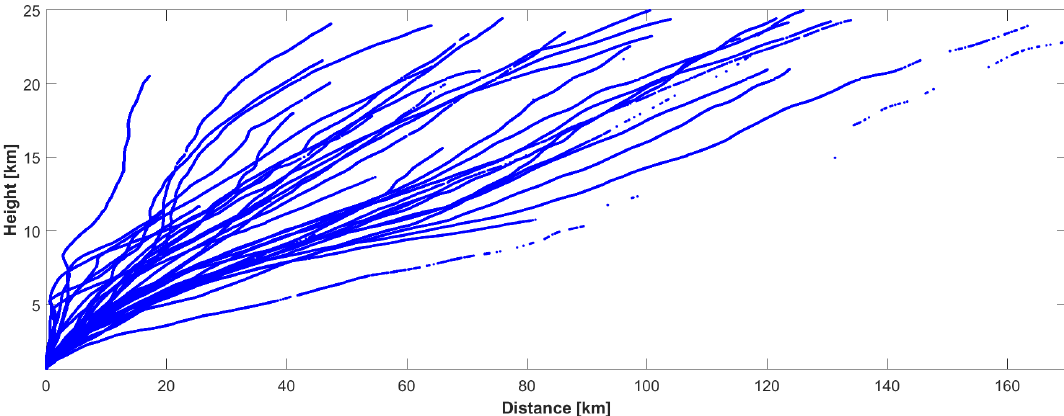
Figure 3. Height–distance plot of all balloon ascents. The height axis is exaggerated by a factor of 2.